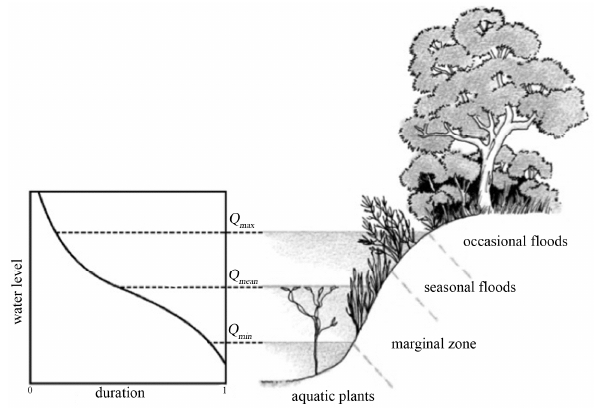
Figure 1. Scheme of alluvial river: riparian vegetation and water flow.